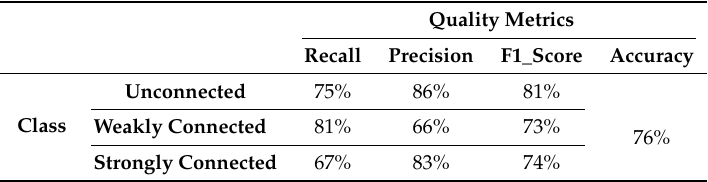
Table 3. Quality metrics for multi-class